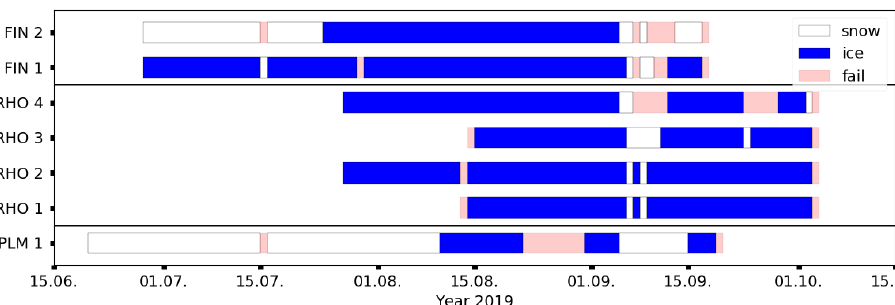
Figure 3. Overview of camera station availability during summer 2019. Cameras have been mounted and torn down at different times due to weather and staff restrictions. Station names are defined in Table 1. The category “snow” means that the glacier surface is snow covered, “ice” indicates that bare ice is exposed, and “fail” indicates either a failure in image transmission, station maintenance, or the inability to read the mass